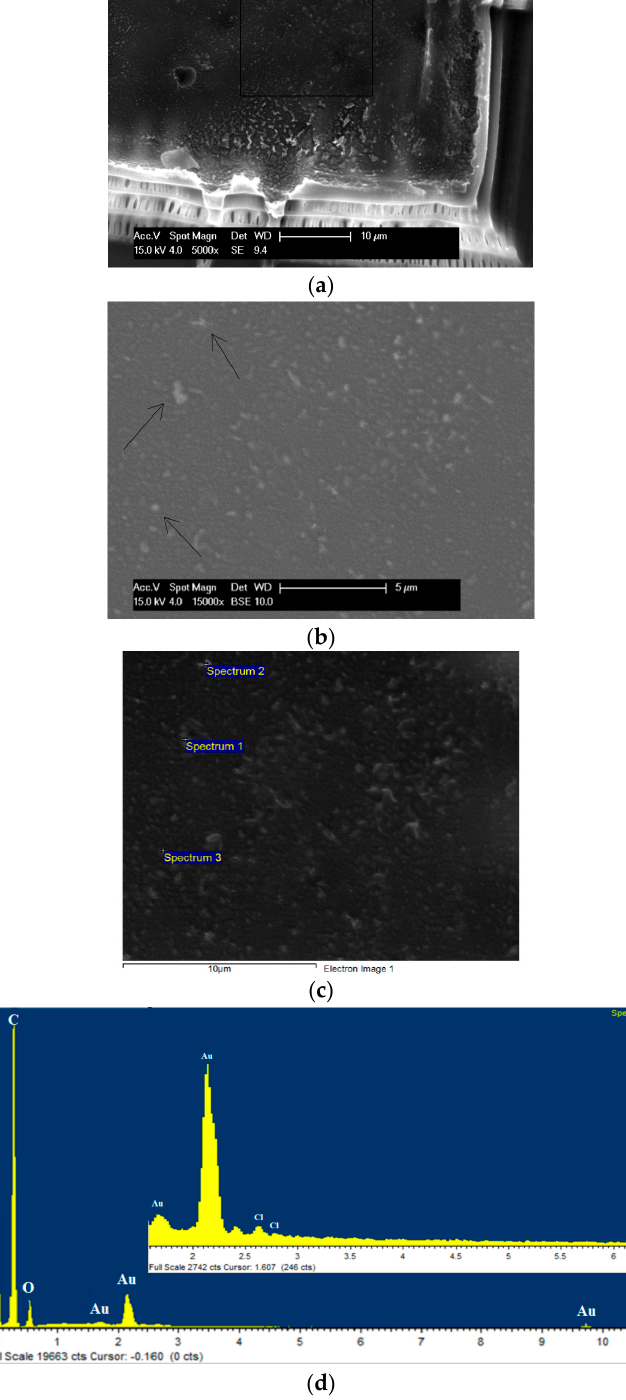
Figure 7. ( a ) Scanning electron microscope (SEM) image of a part completed 3D fabrication using Formulation 5; ( b ) a backscattered electron (BSE) image of the fabricated structure from ( a ) showing the location of suspected gold particles (arrows indicate location of particles) at higher magnification; ( c ) SEM image of Energy dispersive X-ray spectroscopy (EDX) of the area; and ( d ) EDX spectrum of the particles at location 3.